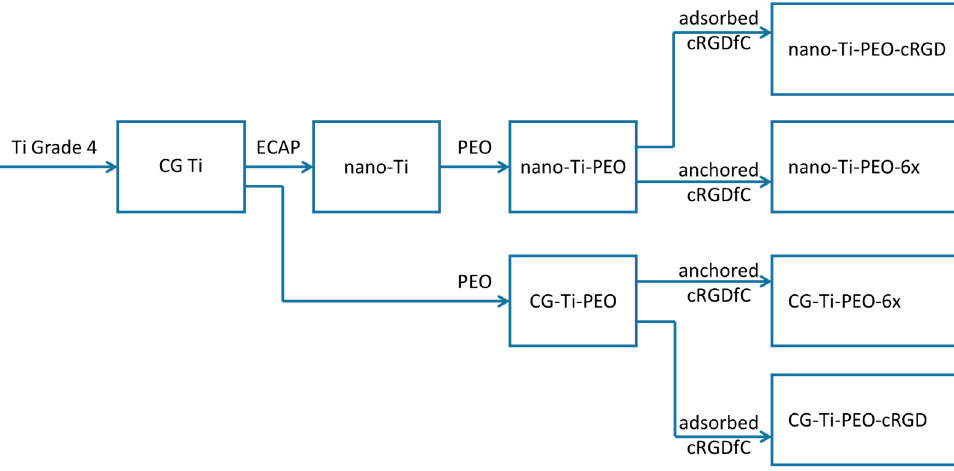
Figure 1. Experimental design scheme showing the steps of the sample